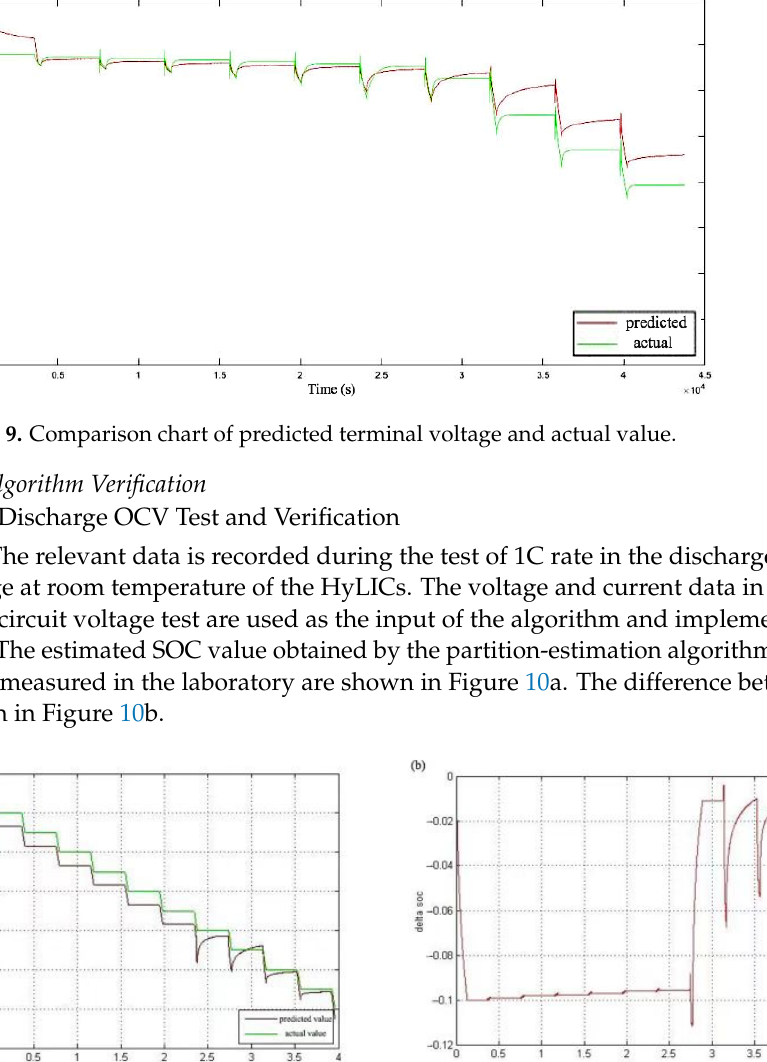
Figure 9. Comparison chart of predicted terminal voltage and actual value.